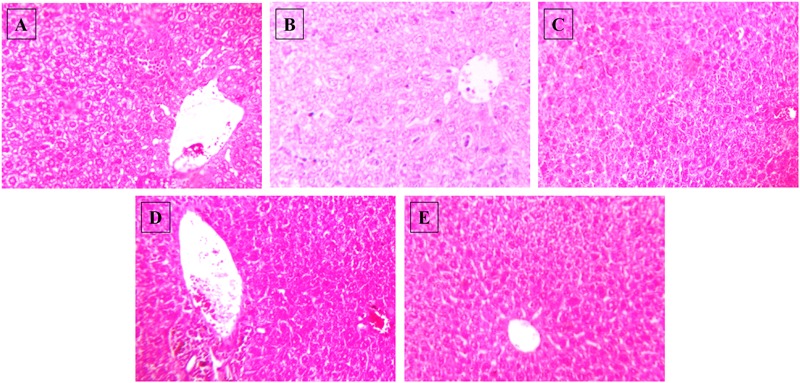
Effect of NAT-1 and NAT-2 on morphological feature of mice liver. Optical microscopy: H&E (200×). Photomicrographs of representative mice are shown. (A) Normal control; (B) HSD fed control; (C) HSD fed mice treated with metformin; (D) HSD fed mice treated with NAT-1; (E) HSD fed mice treated with NAT-2.